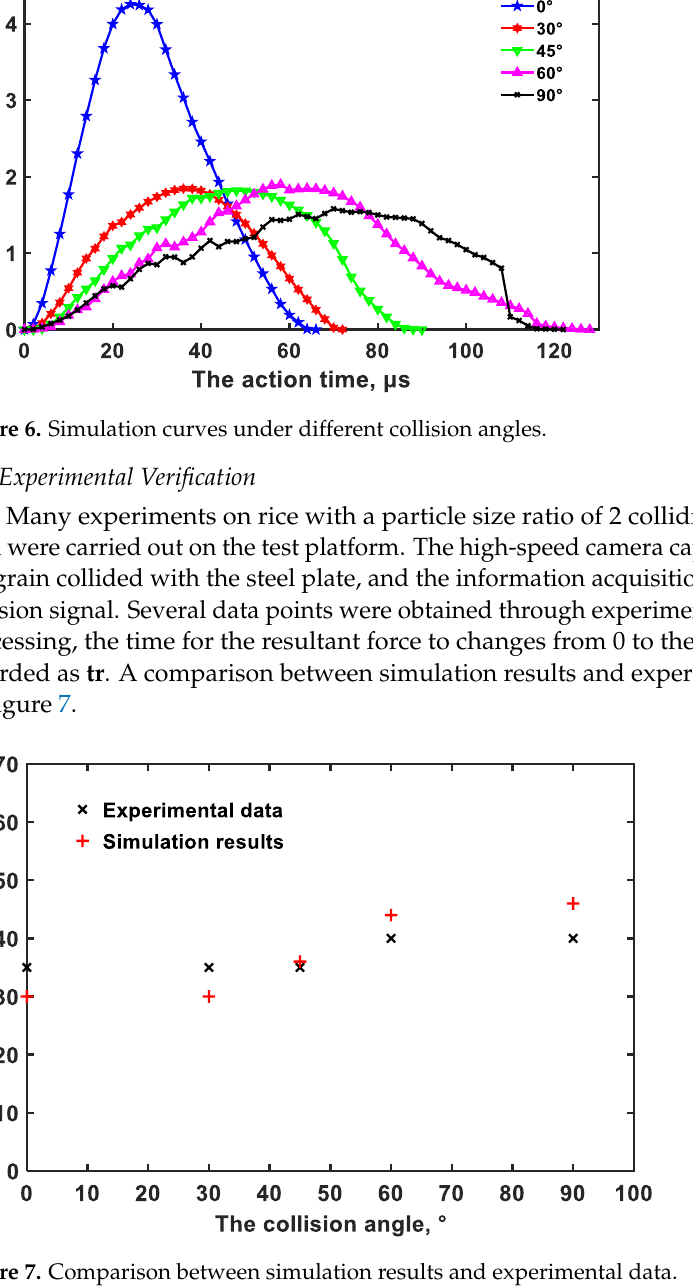
Figure 7. Comparison between simulation results and experimental data.